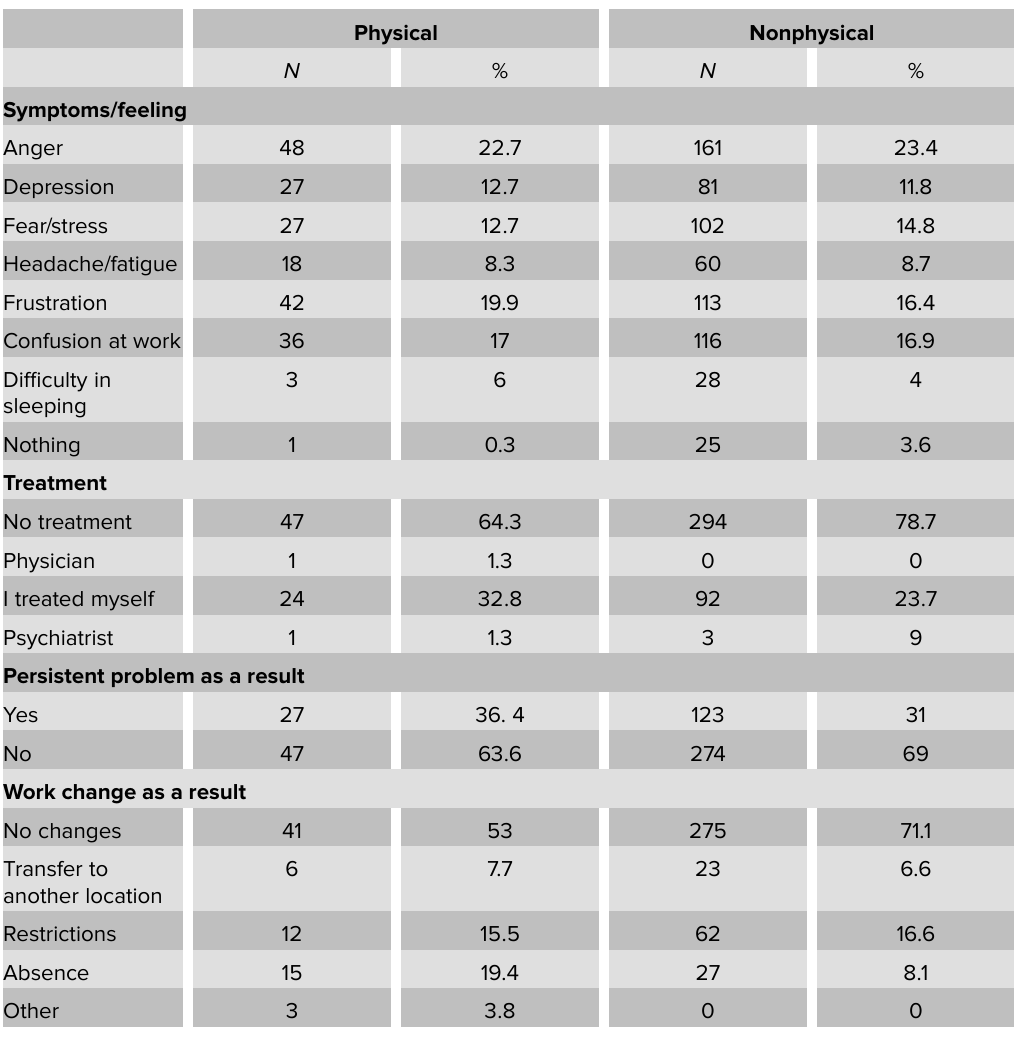
TABLE 4: Characteristics and consequences of violent